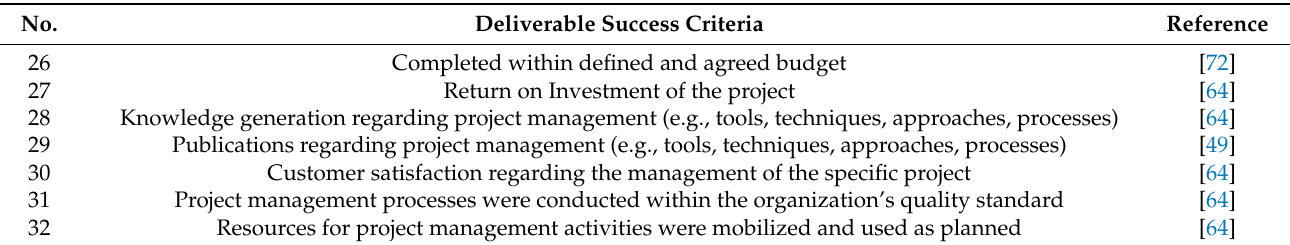
Table 3. Deliverable Success Criteria.